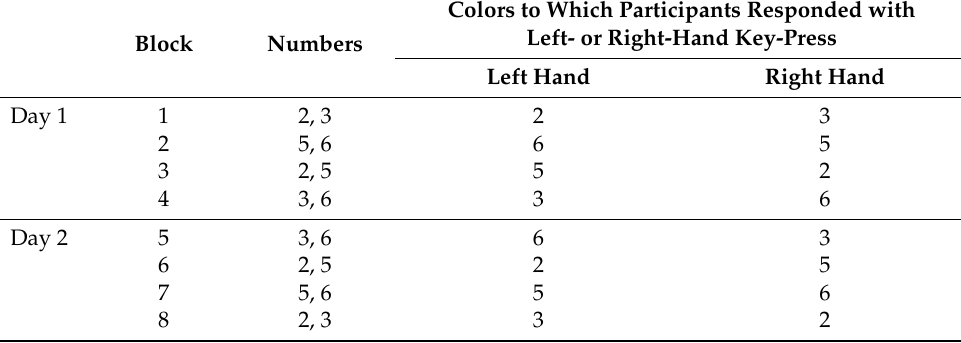
Table 1. Arrangement of numbers and hands for responses to colors in each block (a number in a color column denotes the color corresponding to that number). For participants who used other number sets (2, 3, 4, 6 or 2, 4, 5, 6), 4 took the place of 5 or 3. Colors to Which Participants Responded with Left- or Right-Hand Key-Press Block Numbers Left Hand Right